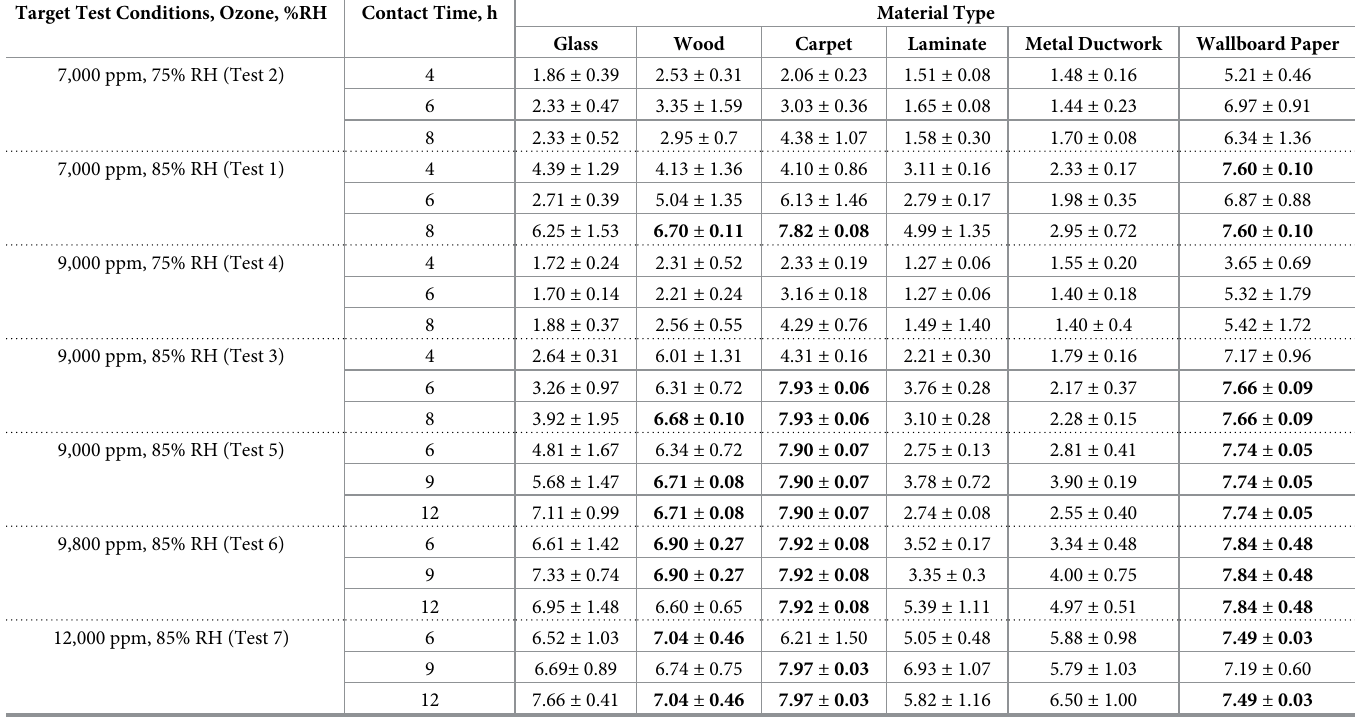
Table 6. Inactivation (Log reduction) of B . anthracis spores. Target Test Conditions, Ozone,